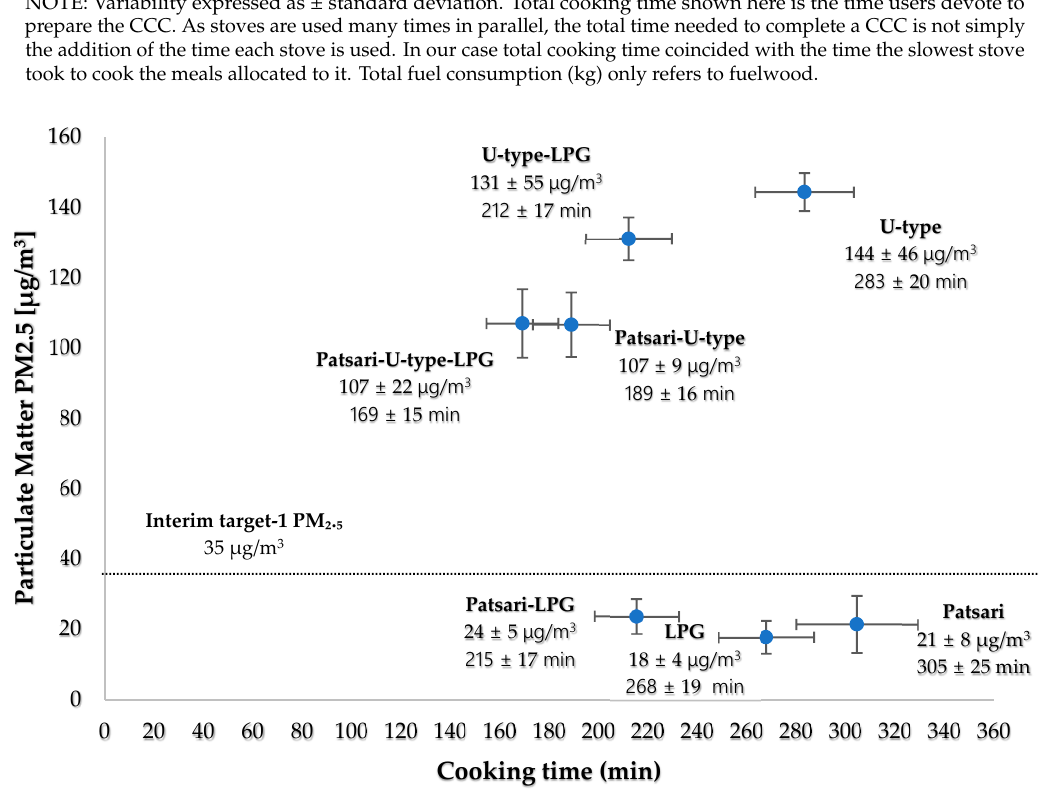
Figure 4. Cooking time and 24-h concentrations of PM 2.5 for CCC. The blue dots represent concentration averages and whiskers are ± 1 standard deviation of the measurements.